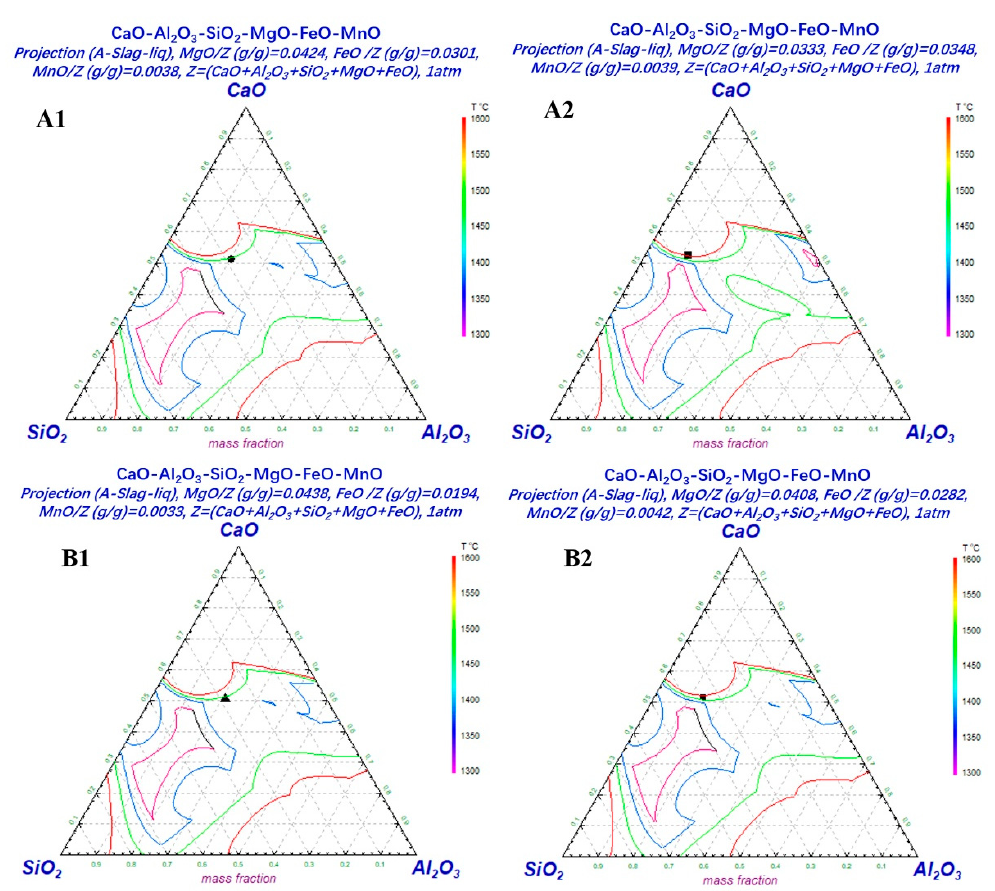
Figure 10. The liquidus line projection of the tundish covering flux before and after plasma heating: A1, A group: before heating; A2, A group: after heating; B1, B group: before heating; B2, B group: after heating.